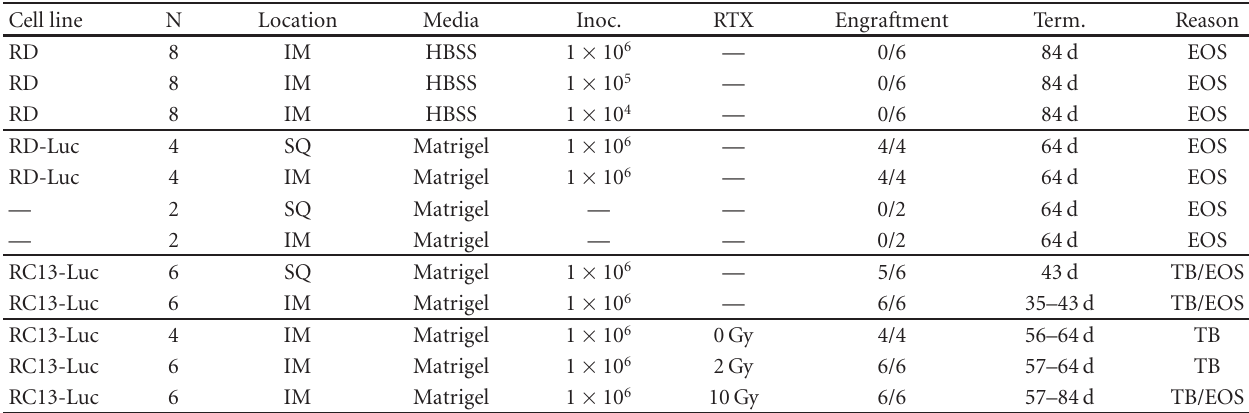
Table 1: Experimental design: IM: intramuscular inoculation; SQ: subcutaneous inoculation; HBSS: Hank’s bu ff ered salt solution; Inoc.: approximate number of cells inoculated; RTX: radiation therapy; Gy: Gray, units of absorbed radiation; Term.: day of study when mice were euthanized; EOS: end of study; TB: euthanized due to tumor burden. Location Media Inoc. Engraftment